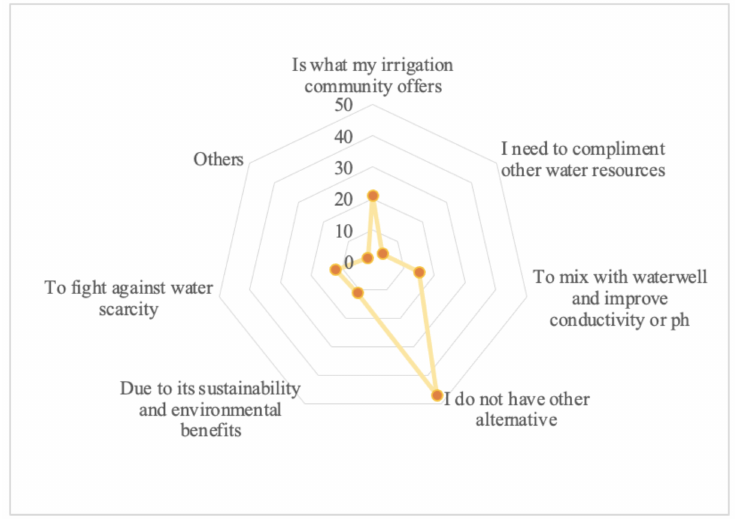
Figure 3. Farmers’ initial reasons for using reclaimed